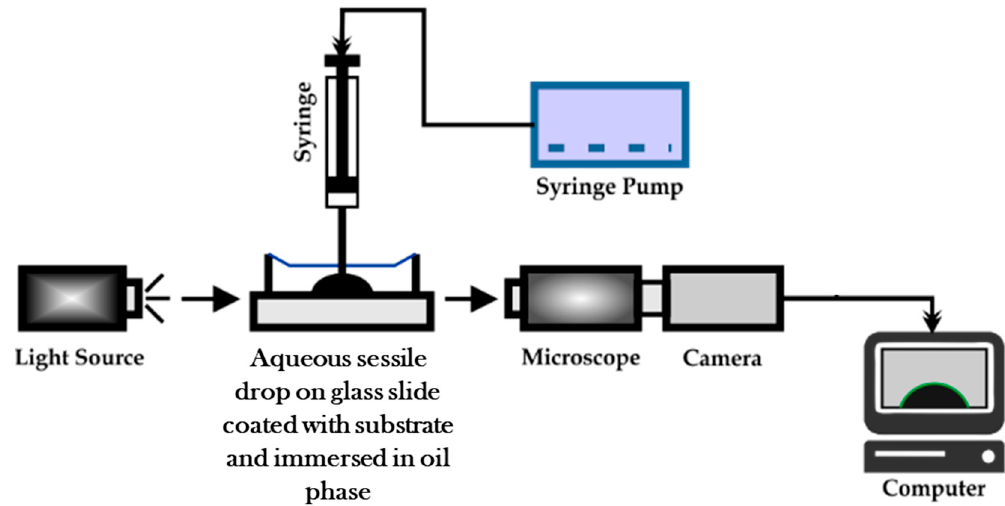
Figure 2. Schematic of the sessile drop method for measuring contact angle.